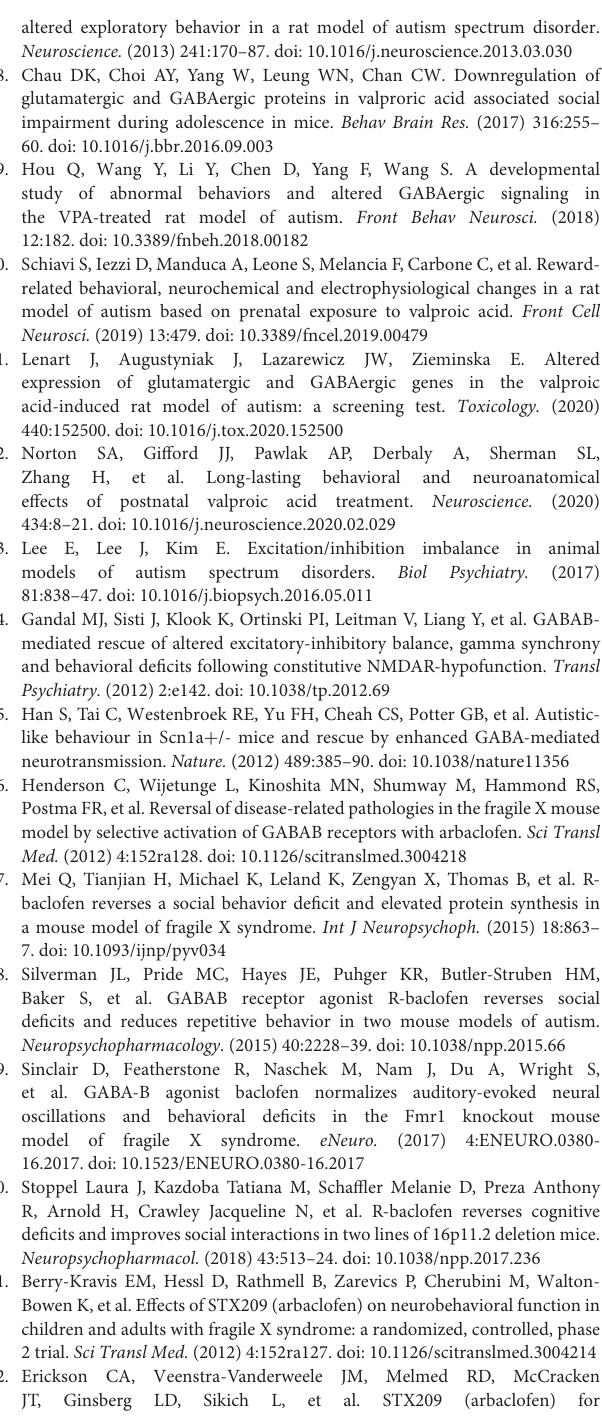
Supplementary Figure 2 | Flowchart for behavioral test. Supplementary Video 1 | Social interaction test(scene 2, F2-Con). Supplementary Video 2 | Novel object recognition task(scene 2, F2-Con). Supplementary Video 3 | Novel object recognition task(scene 2, F2-Int). Supplementary Video 4 | Open-field task